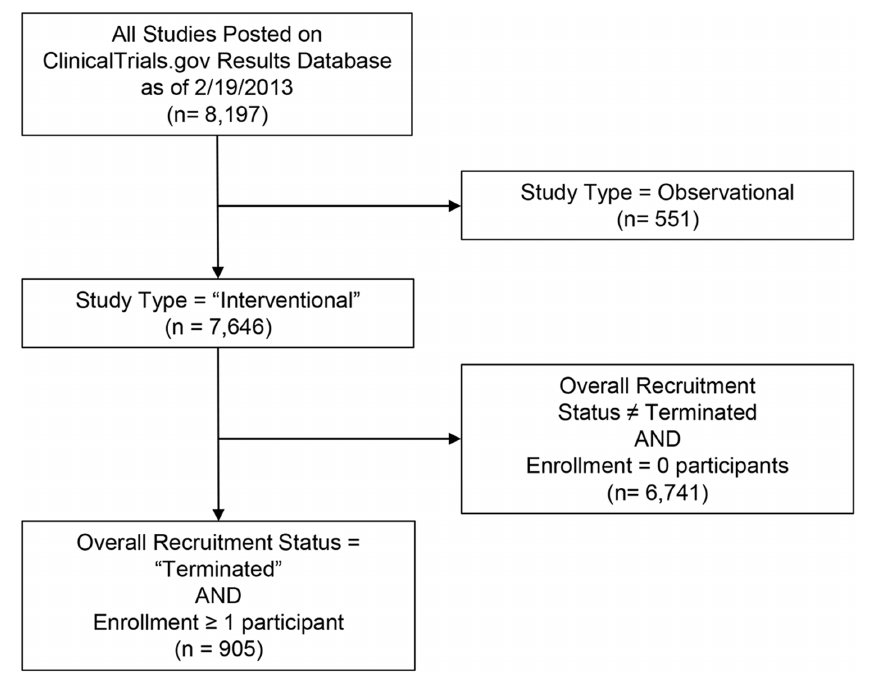
Fig 1. Study Inclusion Criteria. Presents ClinicalTrials.gov data elements and values used to filter records. Study Type of “ Interventional ” refers to clinical